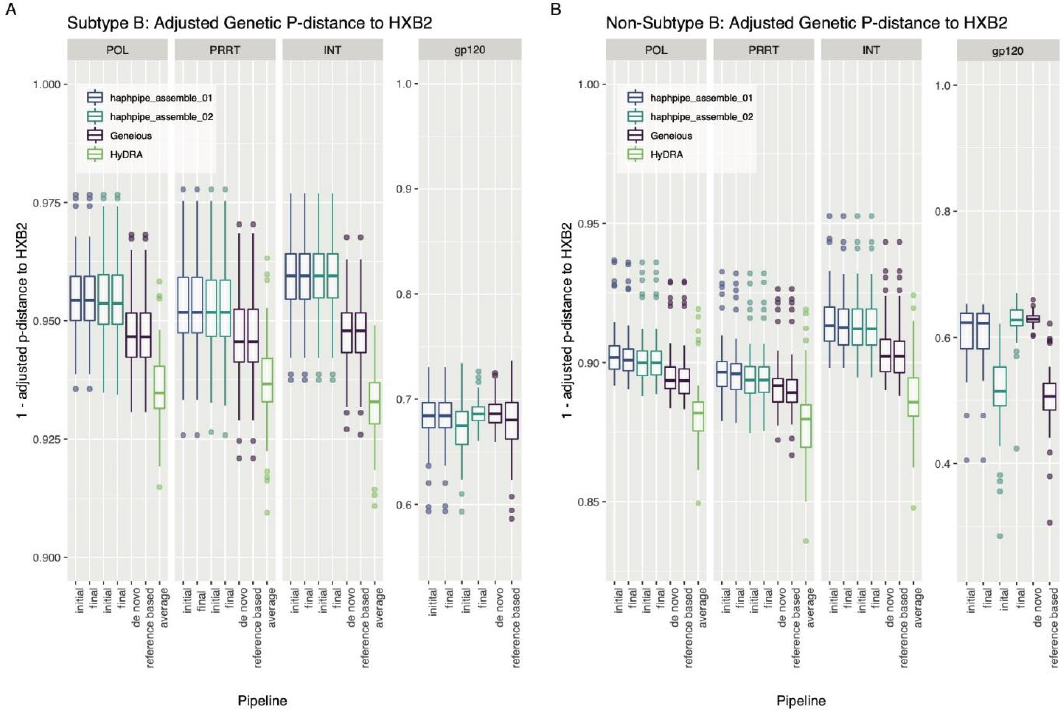
Figure 3. Adjusted genetic p-distance (displayed as a difference from 1) between consensus sequence and HXB2, the reference sequence for HIV, for all pipelines for the simulated HIV ( A ) subtype B dataset and ( B ) non-subtype B dataset. Ambiguous nucleotides were accounted for by giving fractional weight in alignment. A value closer to 1.00 indicates that the consensus sequence is more genetically similar to the reference sequence. The x-axis order from left to right for an individual panel: adjusted genetic p-distance between the reference sequence and (i) the initial assembled sequence followed by (ii) the final assemble sequence for haphpipe_assemble_01 pipeline (de novo assembly); (iii) the initial assembled sequence followed by (iv) the final assemble sequence for haphpipe_assemble_02 pipeline (reference-based assembly); the final consensus sequence for the Geneious (v) de novo workflow and the (vi) reference-based workflow; and finally, the (vi) average between the final two sequences (one for each read file) for HyDRA. The three amplicons are shown, as well as a combination of PRRT and int amplicons into pol . There are no results for HyDRA in the gp120 gene because HyDRA only analyzes the pol gene.